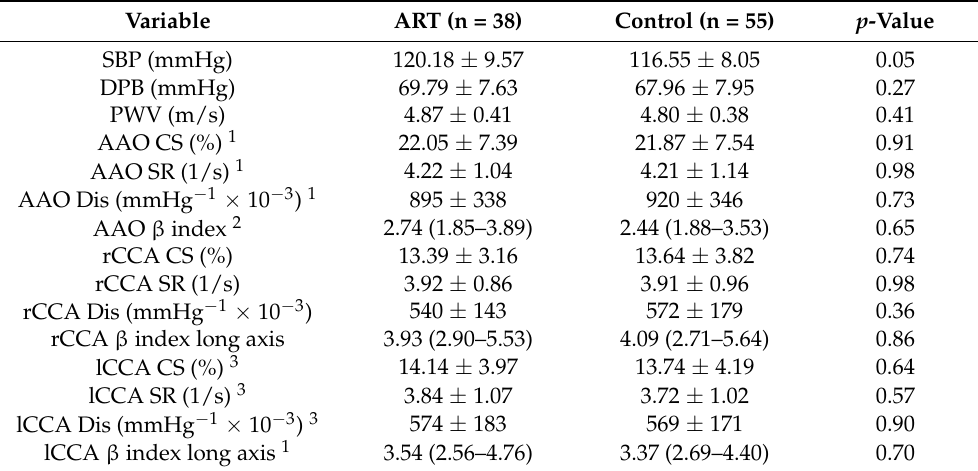
Table 4. Vascular Function in the ART and Control Group Aged ≥ 10 Years.